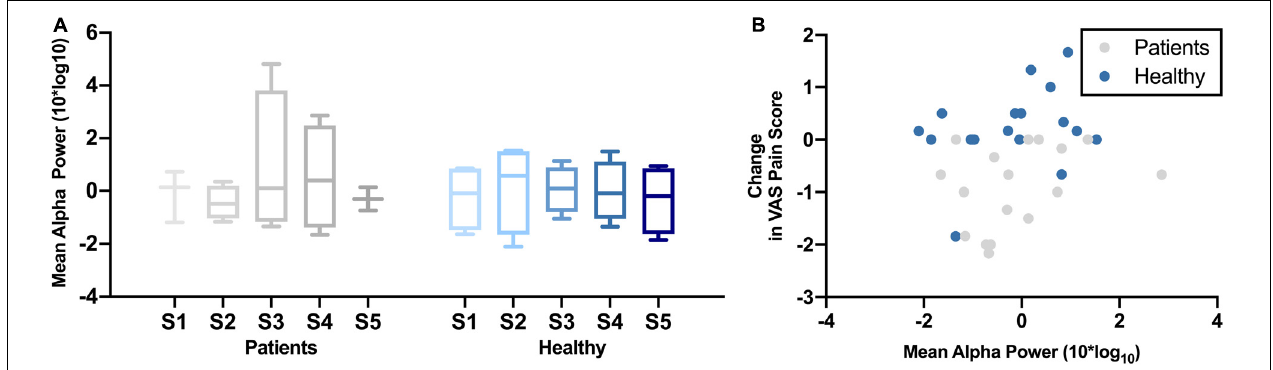
FIGURE 3 | (A) Normalized Mean Alpha Power over five neurofeedback sessions in chronic pain patients and healthy participants. NFB sessions are denoted by S1–S5. (B) Change in mean alpha power during a neurofeedback session and change in VAS pain